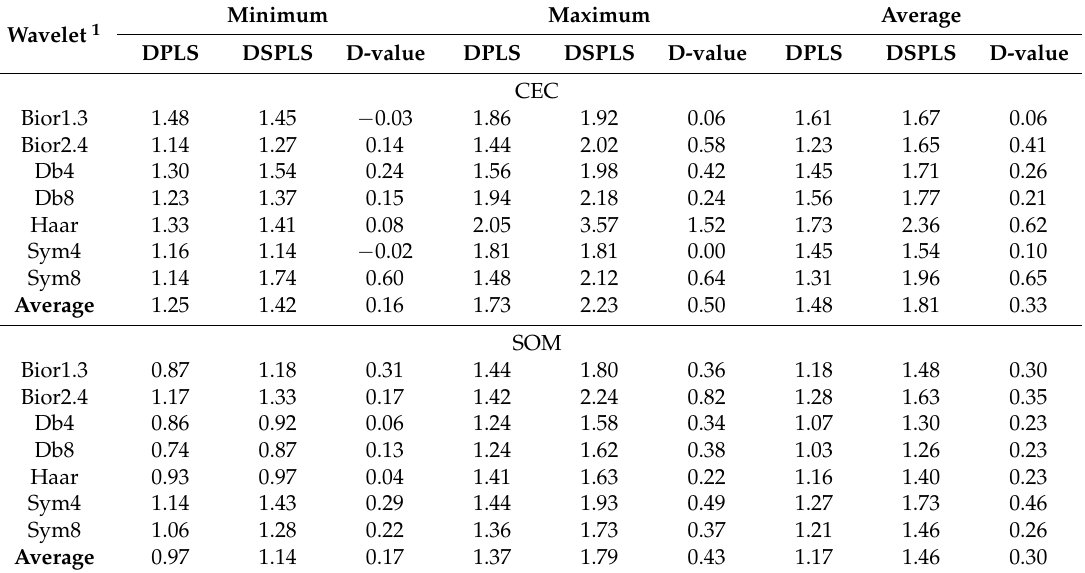
Table 7. Statistical description of relative percent deviation (RPD) between DWT–Stepwise-PLS models and DWT–PLS models for CEC and